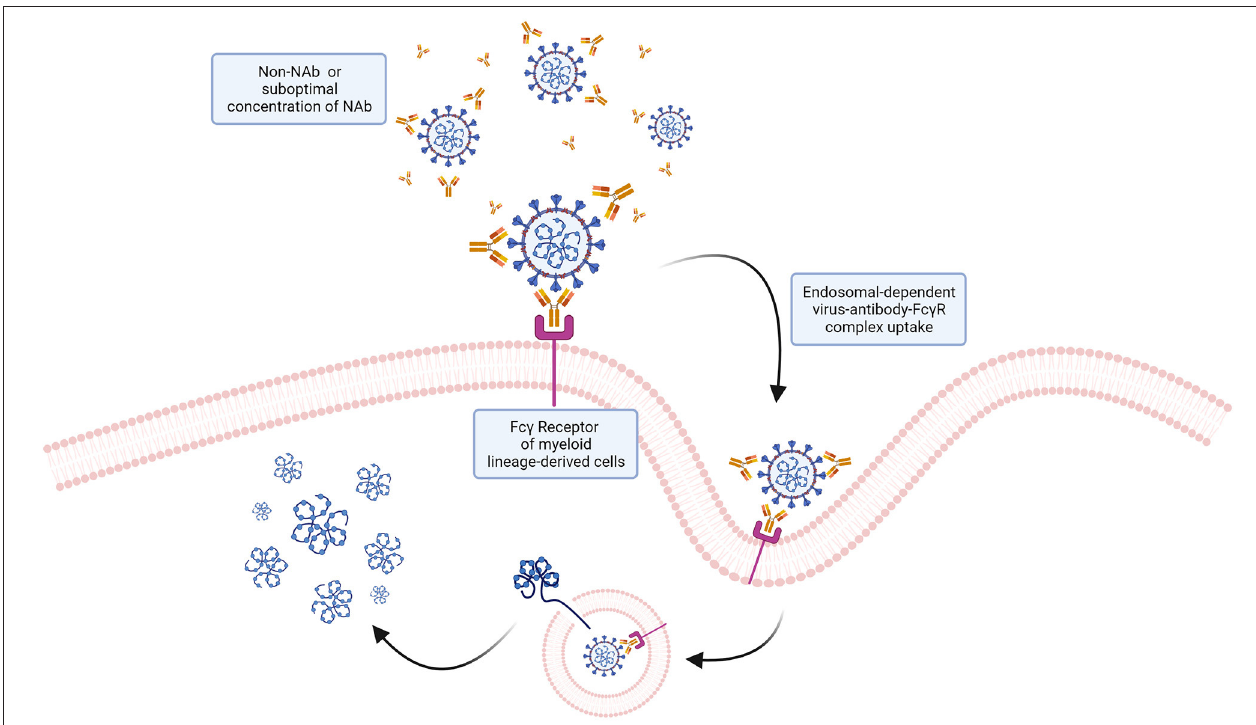
FIGURE 7 | ADE: a potential mechanism of ADE for SARS-CoV-2? Antibodies interacting with virions without neutralizing the ability of the virus to infect target cells could potentially mediate viral particles uptake by cells expressing Fc γ receptors via endocytosis. Internalized virions could then fuse with the endosomal membrane and release the genome into the cytoplasm. While this mechanism, known to favor infection of other viruses, has been hypothesized, no evidence so far has demonstrated that ADE occurs with